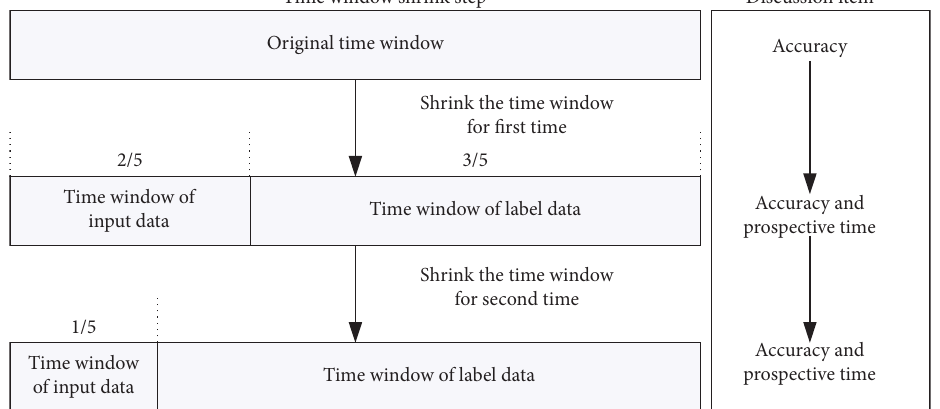
Figure 9: Model training procedure.